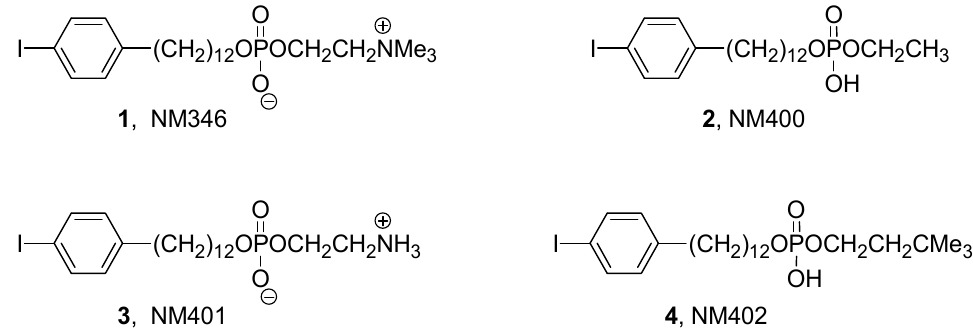
Figure 2. Structures of polar head group modified alkyl